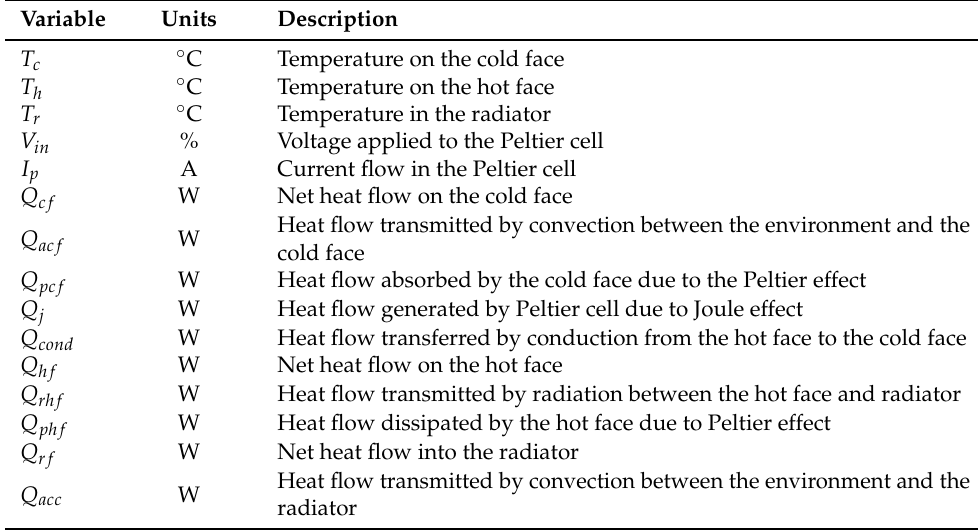
Table 8. Description of variables for the Peltier cell model.